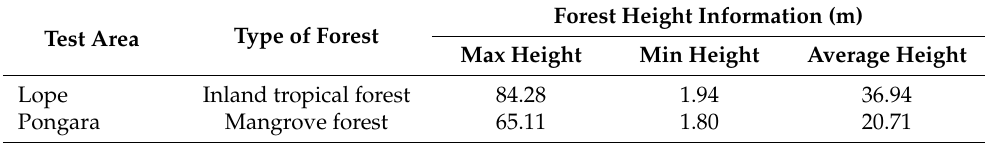
Table 1. Forest conditions.